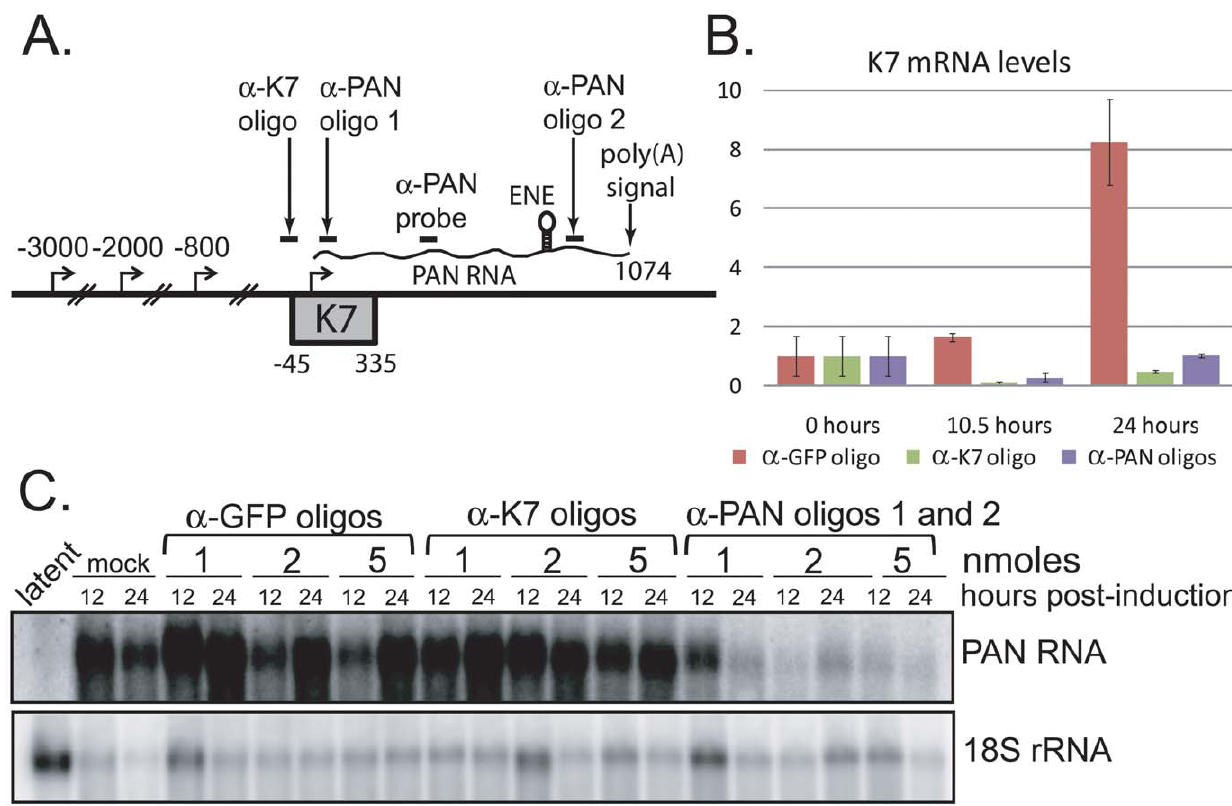
Figure 4. PAN RNA and K7 mRNA levels are reduced by transfection of RNase H-targeting oligonucleotides. A. Region of the KSHV genome from which K7 mRNA and PAN RNA are transcribed. Alternative transcriptional start sites for the K7 mRNA isoforms [40], regions targeted by anti-K7 ( a -K7) and anti-PAN RNA ( a -PAN) 1 and 2 modified oligonucleotides, as well as the oligonucleotide probe used to detect PAN RNA by northern blot, are indicated. The K7 ORF, ENE and poly(A) signal shared by all four RNA species are shown. B. K7 mRNA levels at 0, 10.5 or 24 hours post-induction of BCBL1 TReX-RTA cells after recovery from electroporation with a -GFP, a -K7 or a -PAN RNA 1 and 2 oligonucleotides. qRT-PCR signals were normalized to endogenous 18S rRNA. C. Northern blot analysis of total RNA extracted from BCBL1 TReX-RTA cells electroporated with different concentrations of a -GFP, a -K7 or a -PAN RNA 1 and 2 oligonucleotides and at 0, 12 or 24 hours post-induction. (Fig. 4A, a -PAN oligos 1 and 2) that are not seen upon transfection of the K7-specific oligonucleotide ( a -K7 oligo) would be specifically due to PAN RNA knockdown. First, we showed by qRT-PCR that the K7-specific oligonucleotide selectively lowered the level of the K7 mRNA , 20-fold (Fig. 4B). However, the K7-specific oligonucleotide did not downregulate levels of PAN RNA, as seen in the northern blot of Fig. 4C. The combination of the two anti-PAN RNA oligonucleotides decreased not only PAN RNA to 5%–10% of wild-type levels in BCBL1 TReX-RTA cells (see Fig. 4C), but also the K7 mRNA, as expected (see Fig. 4B). Thus, differential knockdown of the overlapping K7 and PAN transcripts can be achieved by use of modified oligonucleotides. Revealingly, the anti-PAN oligonucleotides had no effect on the host shutoff effect, as indicated by GAPDH and b -actin mRNA levels, despite a knockdown of PAN RNA levels by , 90%–95% (Fig. 5). Transfection with a GFP- or K7-specific control oligonucleotide also did not alter the magnitude of host shutoff in BCBL1 TReX-RTA cells (Fig. S6). Confocal analysis indicated that PABPC1 was re-localized into the nucleus of BCBL1 TReX- RTA cells upon lytic induction despite PAN RNA knockdown (data not shown). We conclude that the expression of PAN RNA may be related to but is not required for SOX-dependent host shutoff during the KSHV lytic phase.